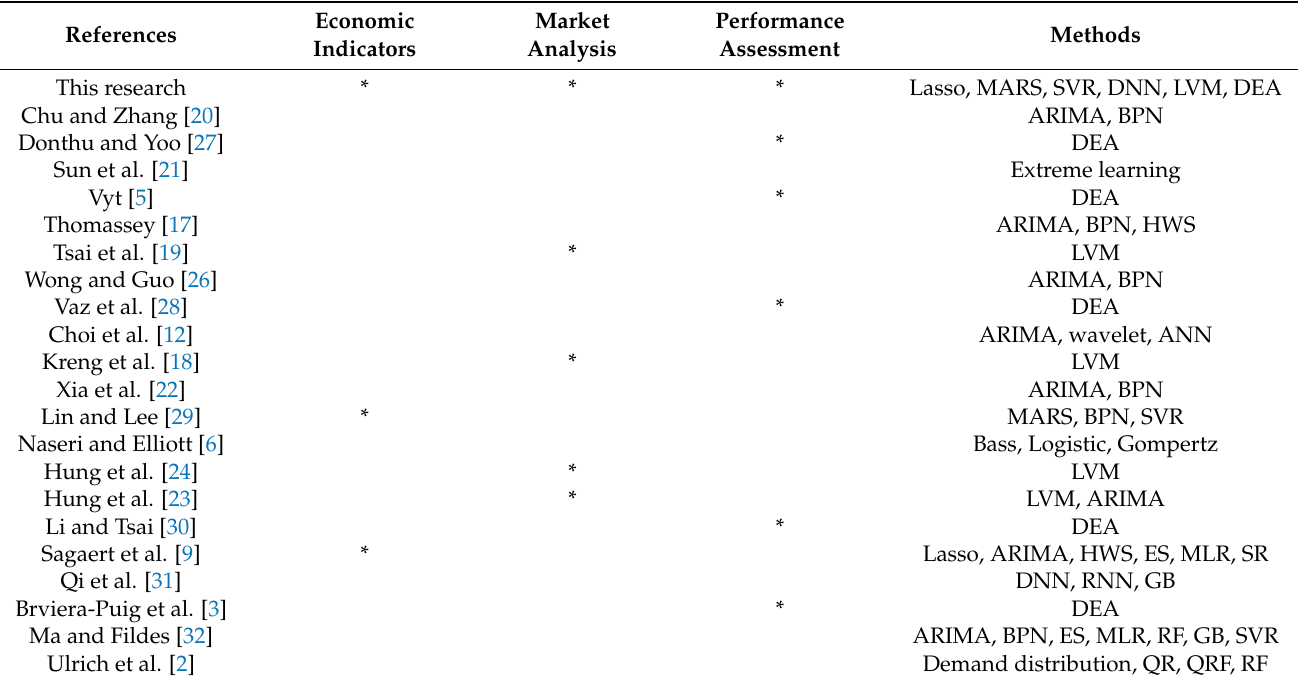
Table 1. Overall comparison between this research and past